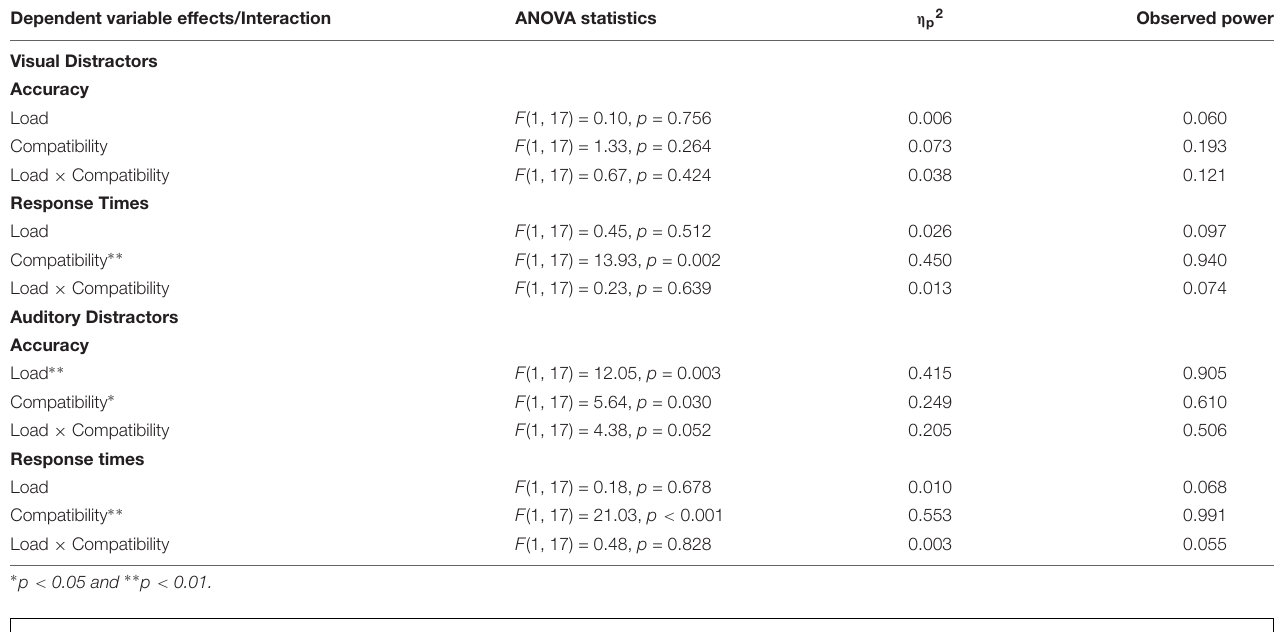
TABLE 4 | Load × Compatibility ANOVA examining effects of visual distractors on accuracy and response times (top), and Load × Compatibility ANOVA examining effects of auditory distractors on accuracy and response times (bottom).